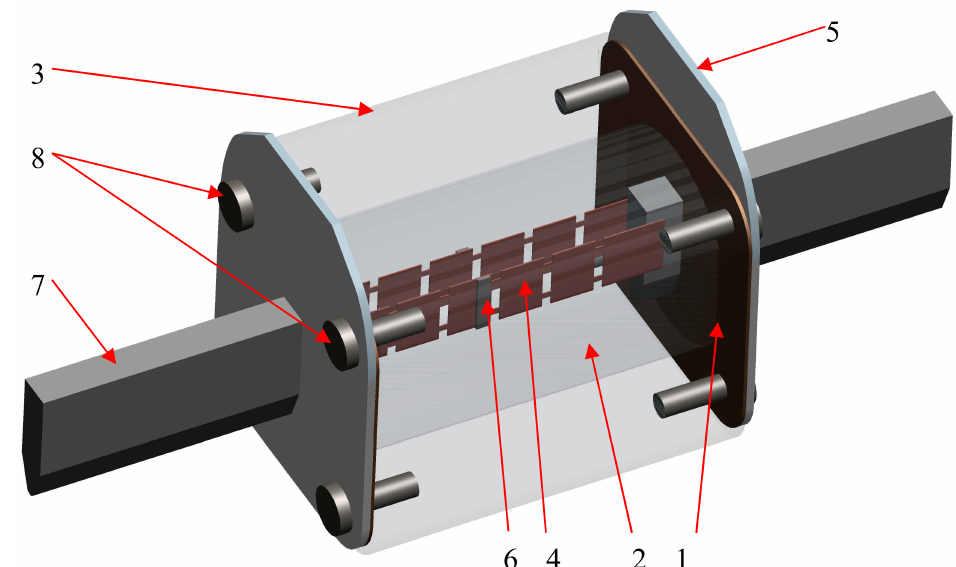
Figure 3. Thermal model of the HBC fuse (1—inner cap; 2—silica sand; 3—ceramic body; 4—fuse link; 5—outer cap; 6—alloy M-effect; 7—knife contact; 8—screws). Table 1. Materials and parameters at 20 ◦ C corresponding to the components in Figure 3. Parameter Material γ (kg/m 3 ) c (J/kg ◦ C) λ (W/m ◦ C) Ceramic/Steatite C221 (3)